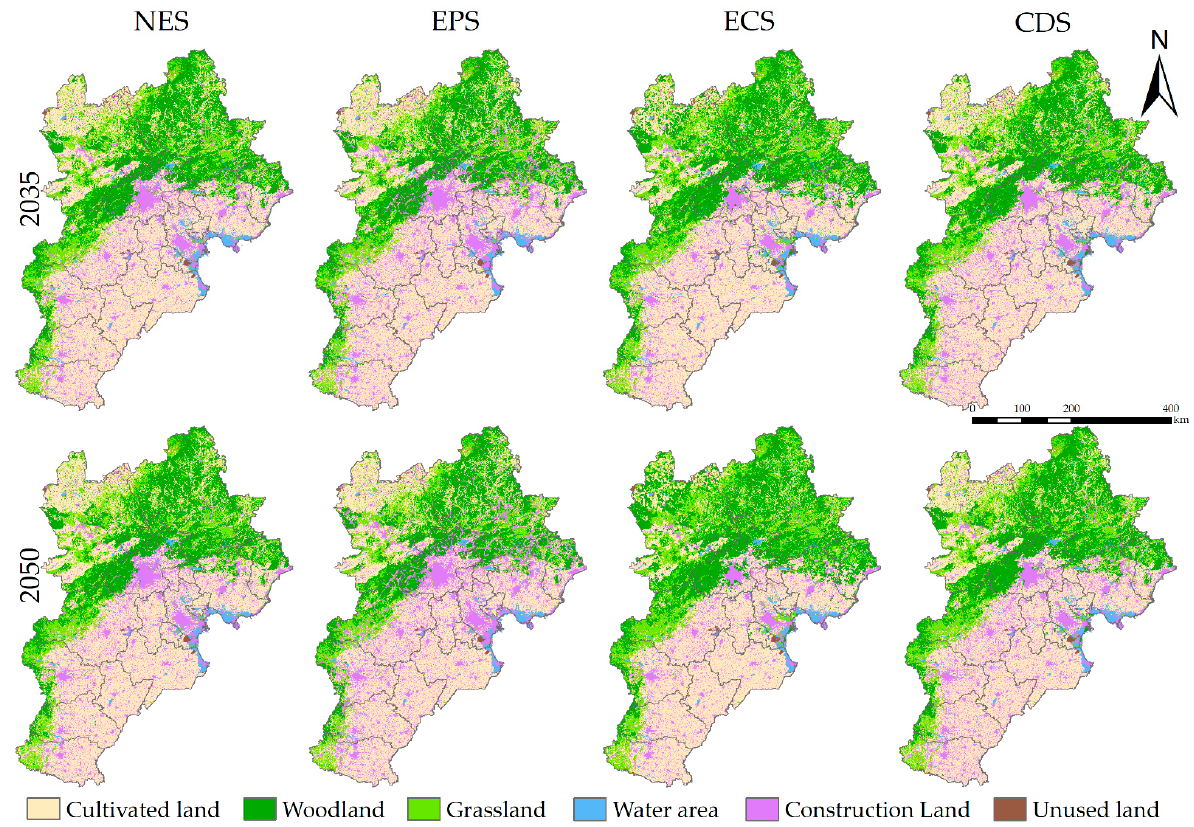
Figure 7. The predicted land-use distributions in 2035 and 2050 under four scenarios.